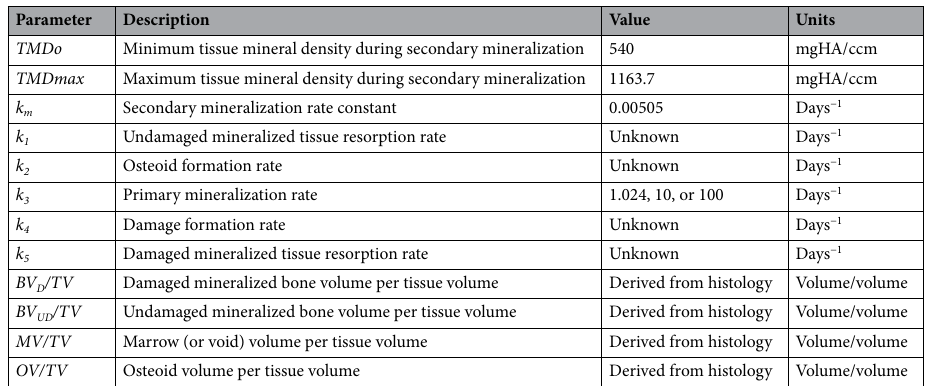
Table 1. Model variables; all predefined values (or ranges) are indicated and variables that were solved for are indicated by